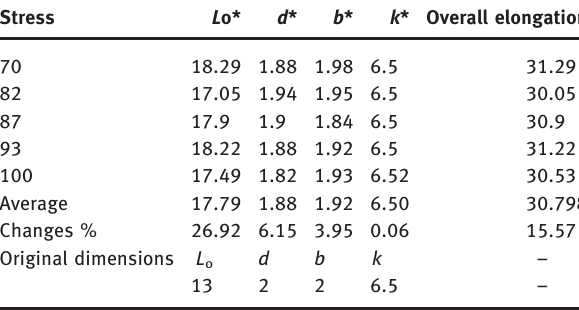
Figure 18. Again, as with the MSR data, very good corre- lation between the uniaxial and the TBS rupture data was obtained.